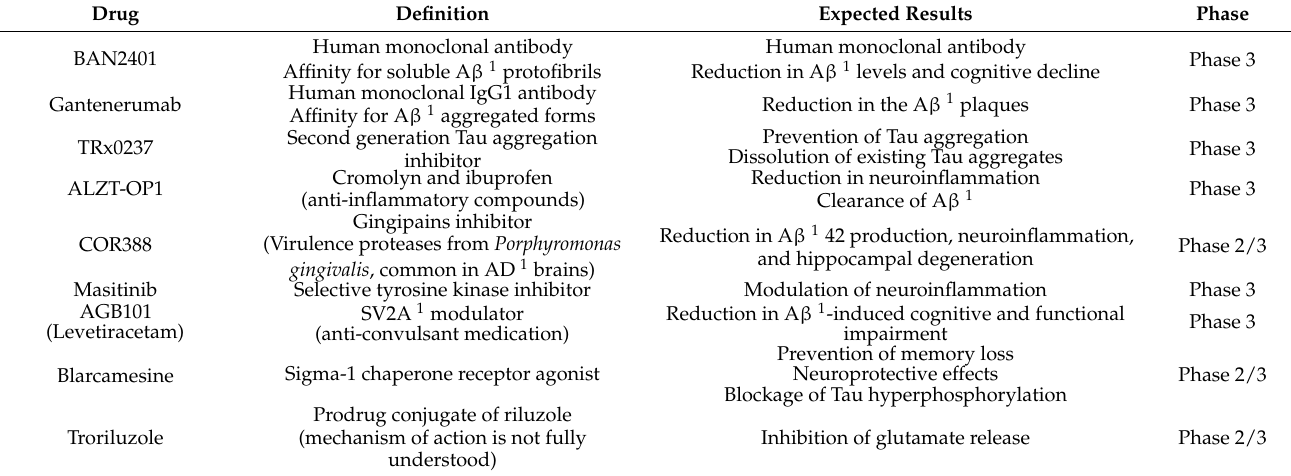
Table 3. Potential therapeutic drugs and applications in AD, currently in clinical